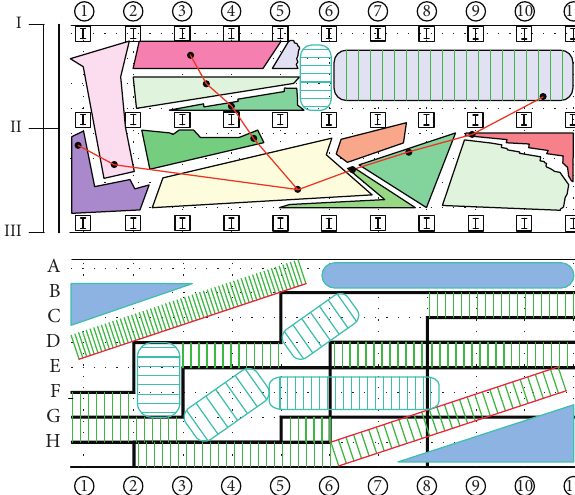
Figure 3: Planning display of civil engineering project based on virtual reality technology.